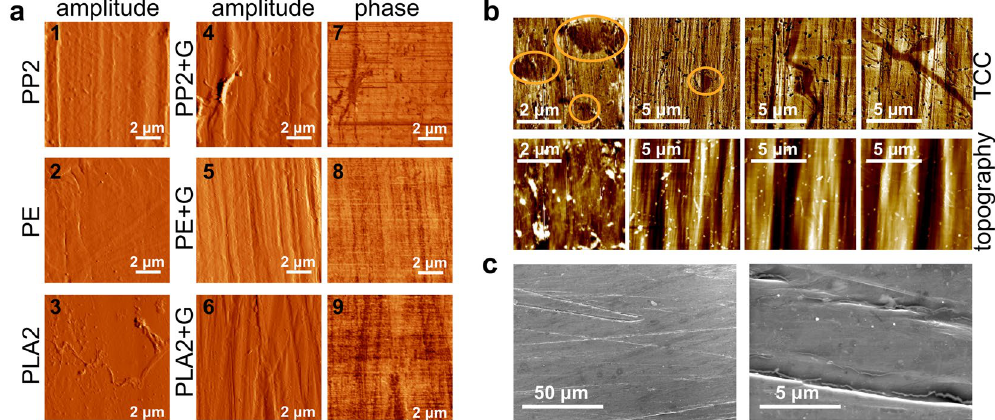
Figure 3. ( a ) Atomic Force Microscopy amplitude images of the fibres before coating: PP1 (1); PE (2) and PLA (3); amplitude and phase images of graphene-coated fibres: PP (4 and 7); PE (5 and 8) and PLA (6 and 9) showing a continuous graphene coverage. ( b ) Scanning Thermal Microscopy thermal conductivity contrast (TCC, top row) and topography (bottom row) images. ( c ) Scanning Electron Microscopy images showing details of holes and cracks in the graphene coverage of PP textile